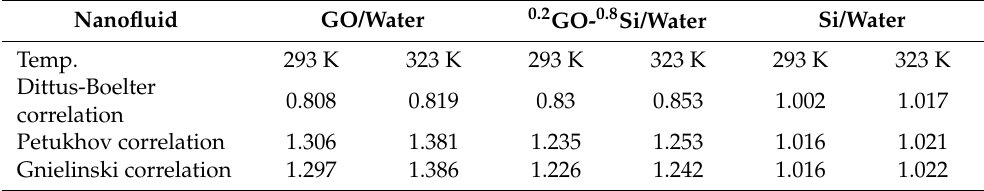
Table 4. Heat transfer coefficient ratio.